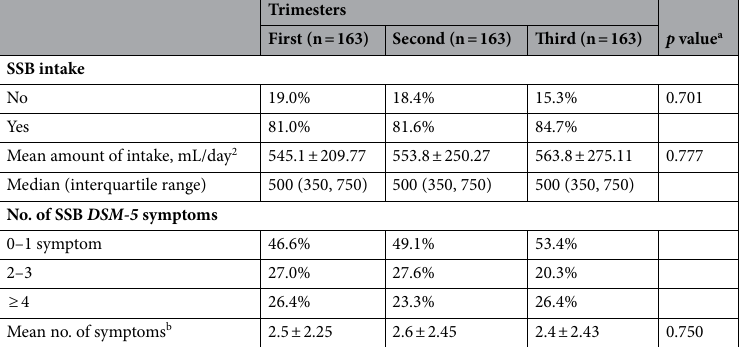
p value a First (n = 163) Second (n = 163) Third (n =